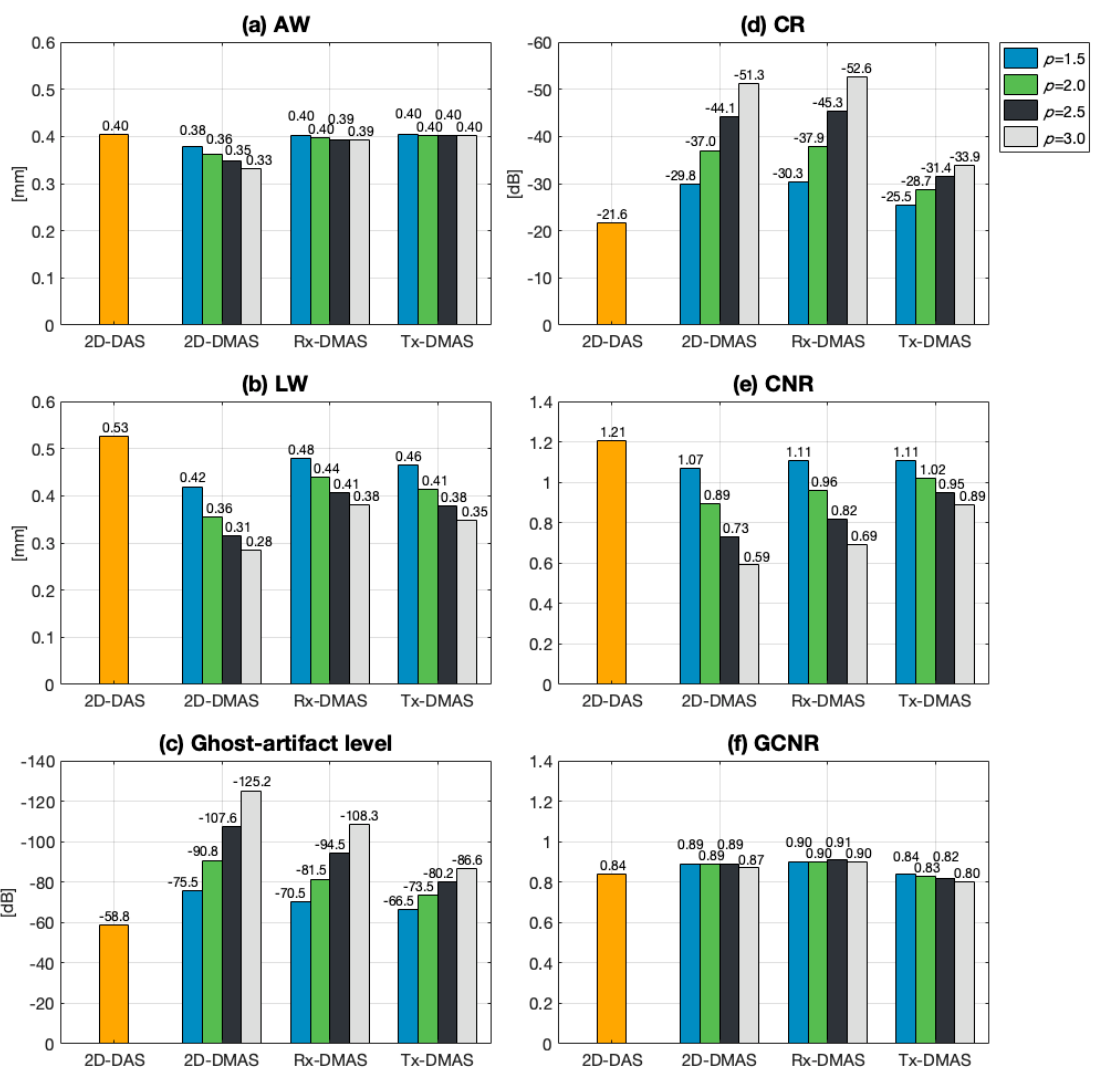
Figure 2. Quantitative analysis of image resolution, ghost-artifact level, and image contrast for the simulated B-mode images in Figure 1.